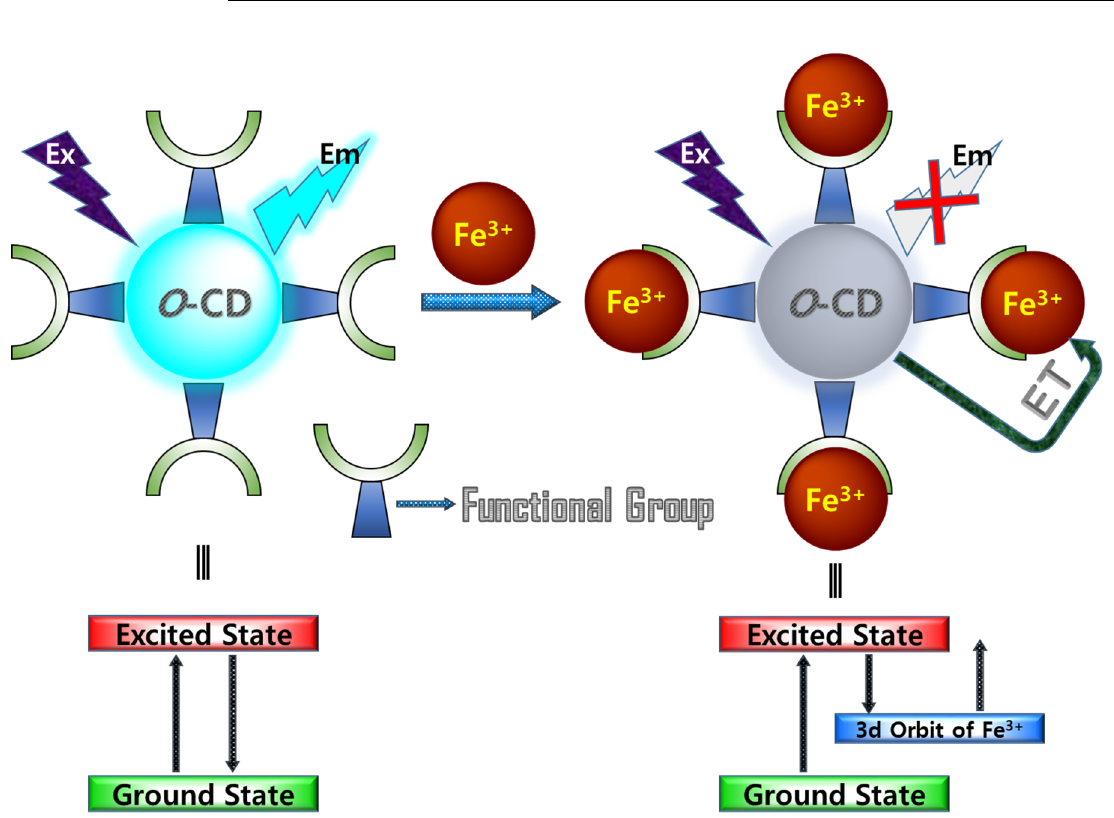
Figure 7. Fluorescence quenching mechanism of the O -CDs in the presence of Fe 3+ ions.